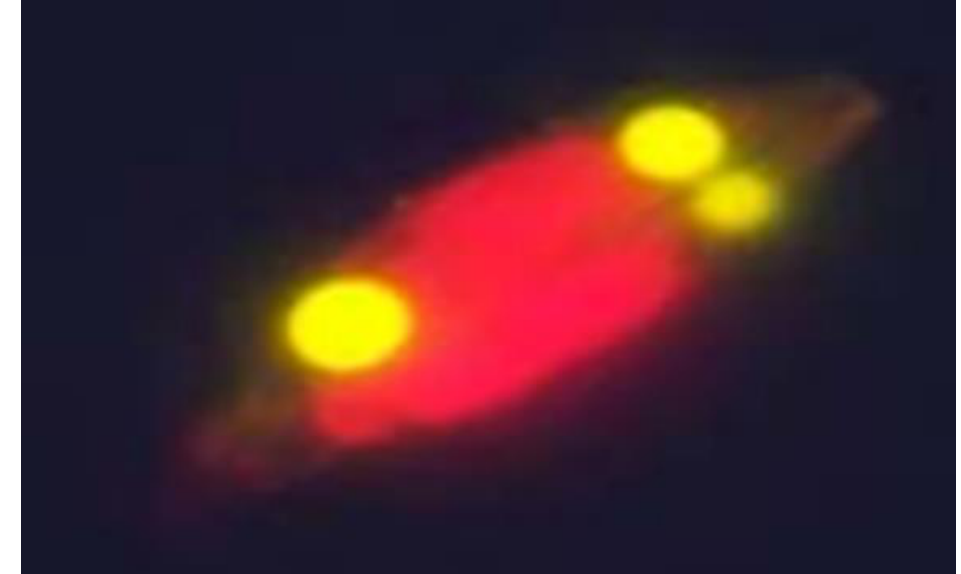
Figure 3. Nile red-stained cells of A. copulata showing oil bodies.